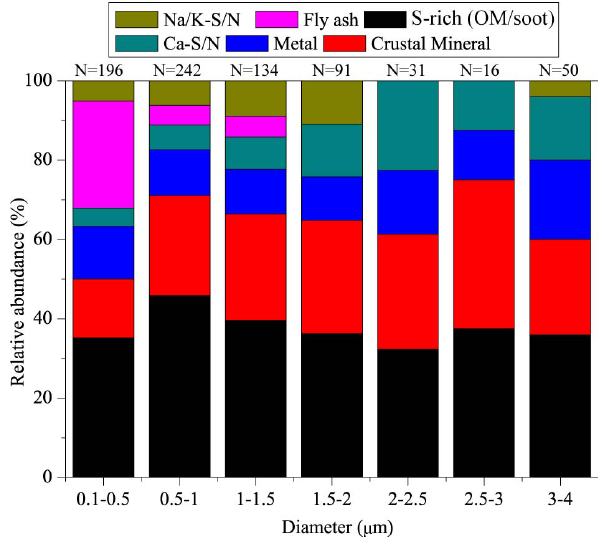
Fig. 5. Proportions of different aerosol particle types in different size ranges. A total of 717 aerosol particles were identified on bases of their different morphologies and compositions. The num- ber of the analyzed aerosol particles in different size ranges is shown above each column. Fly ash, metal, and crustal mineral particles in- ternally mixed with S-rich particles were also included